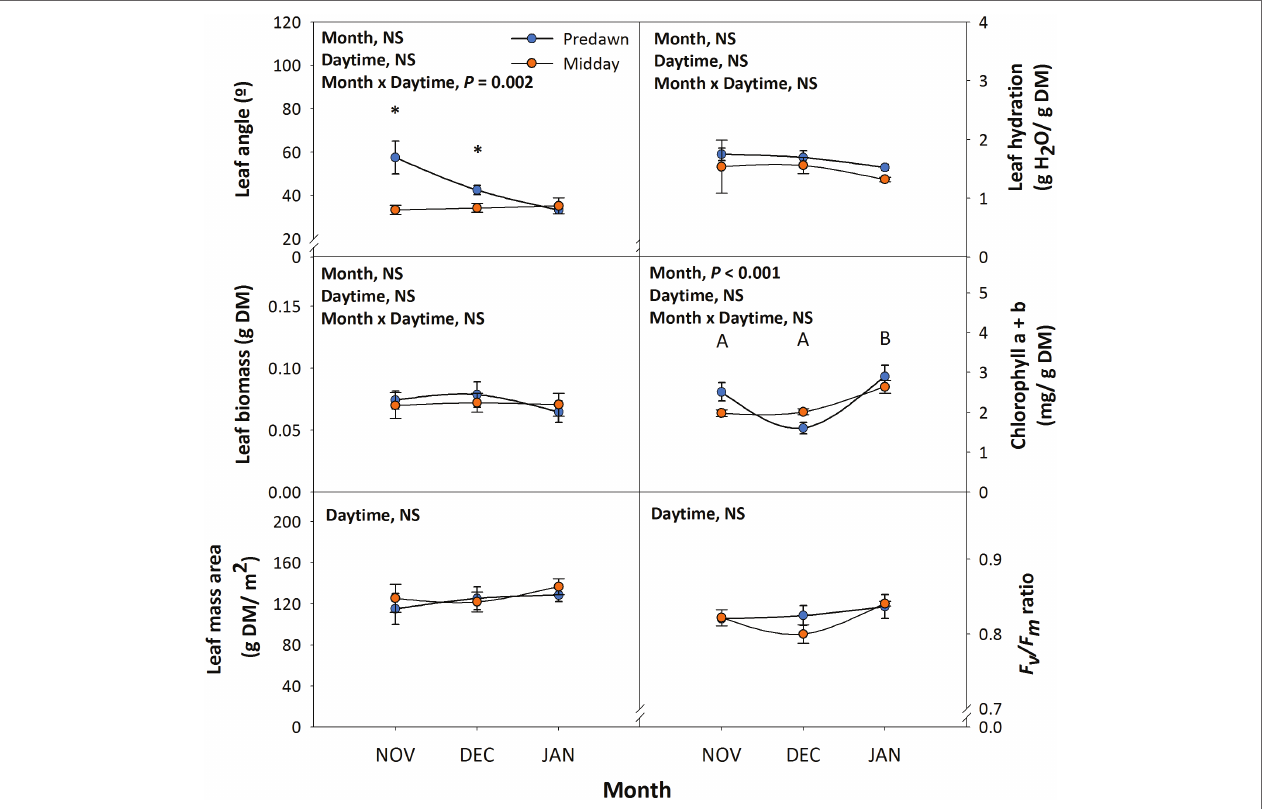
FIGURE 1 | Diurnal and seasonal changes in leaf orientation in the Mediterranean shrub, C. albidus . A comparison of leaf angle, biomass, mass per area ratio, hydration, chlorophyll contents, and the F v / F m ratio between predawn and midday from autumn (November) to winter (January) in plants growing at the experimental garden of the University of Barcelona is shown. Data correspond to leaf position 2 from the apex (see photograph in Figure 3 for details) and represent the mean ± SE of n = 6 individuals. After model selection, significant differences in “Month” and “Daytime” were tested by conditional Fisher tests ( p ≤ 0.05). Different capital letters indicate significant differences in Tukey’s HSD multiple comparison test ( p ≤ 0.05) with all data. Asterisks indicate significant differences in Tukey’s HSD multiple comparison test in “Daytime” within “Month”. NS, not significant; DM, dry